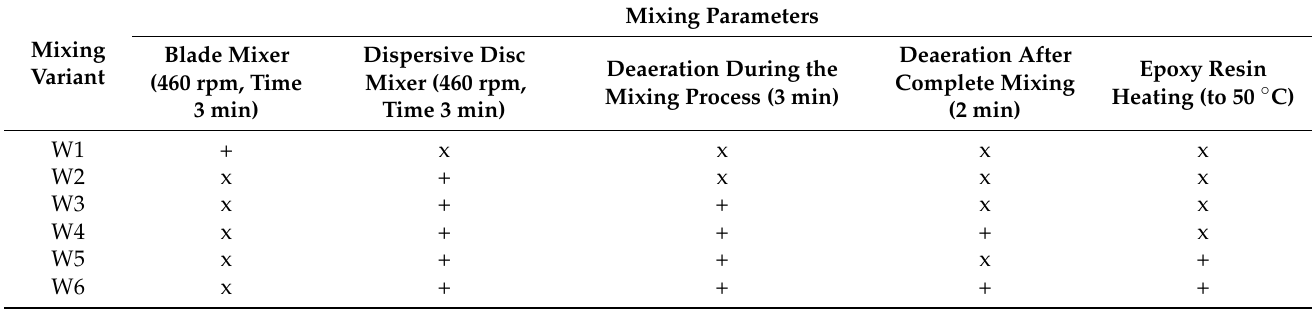
Table 3. Parameters of each mixing